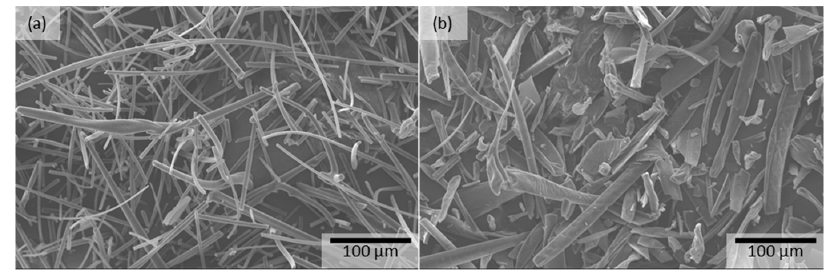
Figure 6. Ground fibers using a hammer mill: ( a ) HP β CD-ASO1–water; ( b ) HP β CD-ASO1–metha- nol/water (10:1) formulation.